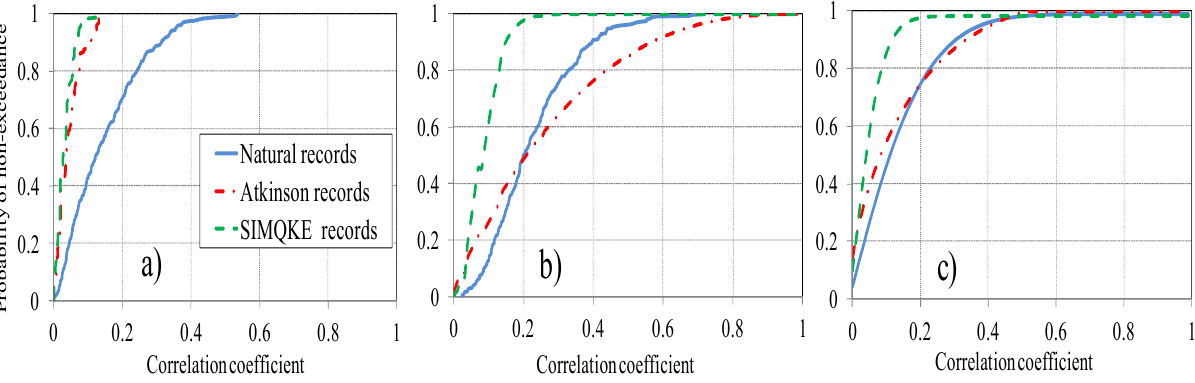
Figure 7. Correlation coefficients between the horizontal components for different record sets for the case of ( a ) as-recorded motions; ( b ) maximum correlation and ( c ) total cumulative probability.